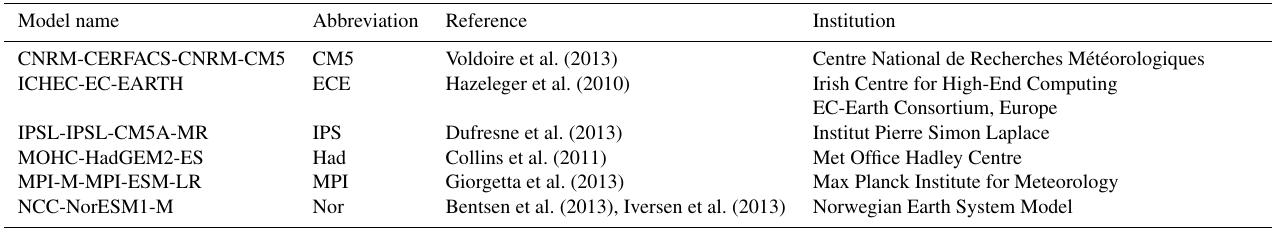
Table 2. List of GCMs, together with the abbreviations used in this paper, included at least once in the EURO-CORDEX ensemble.